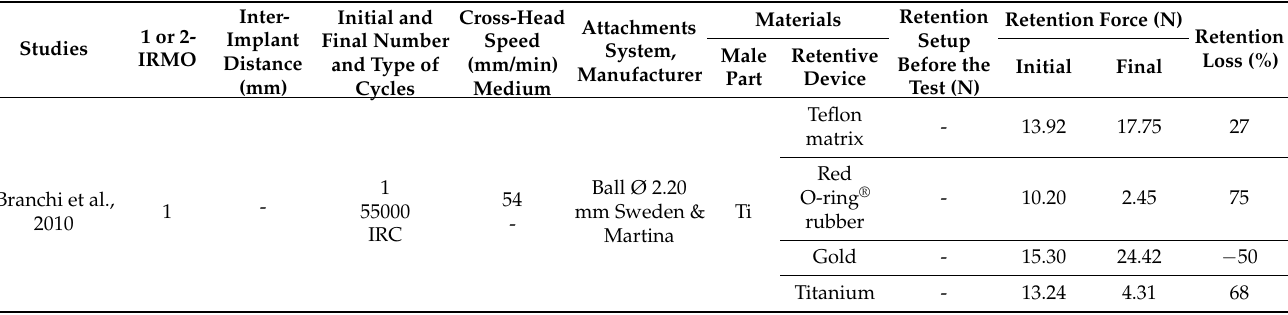
Table 1. Initial retention force (Newton) of ball and cylindrical attachment systems and the influence of insertion–removal (IRC) and/or chewing cycles (CC) on the loss of retention characterized in in vitro studies. Abbreviations: ns, non-significant; Ti, titanium; TiN, titanium nitride. Negative retention loss corresponds to a gain in